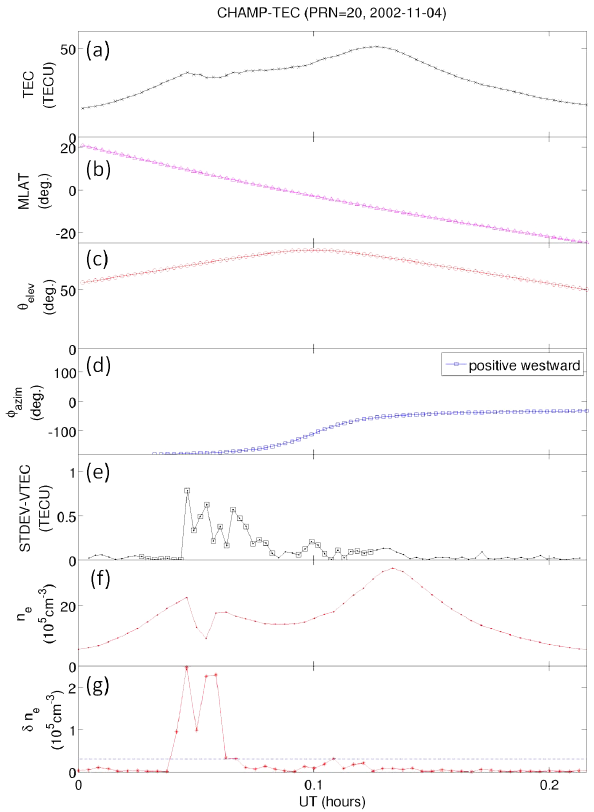
Figure 2. Illustrations of our data processing method: (a) TEC data, (b) magnetic latitude (MLAT) of CHAMP, (c) elevation angle of the GNSS satellite as seen from CHAMP, (d) azimuth angle of the GNSS satellite as seen from CHAMP (counted from geomag- netic north, positive angles are westward), (e) TEC fluctuation level, (f) plasma density measured by the CHAMP/PLP and (g) plasma density fluctuation